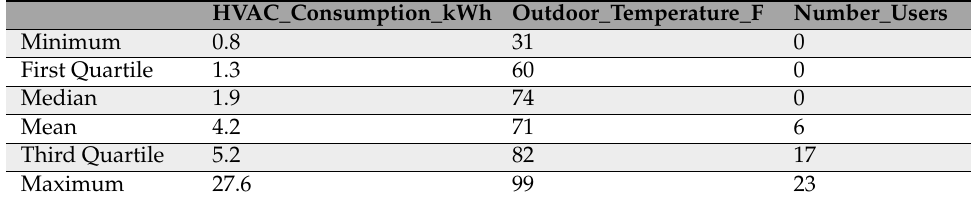
Table 2. A statistical summary of numerical features used in the analysis.